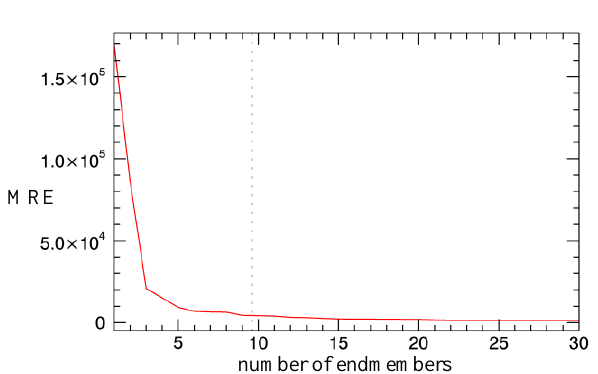
Figure 3 SMACC output: Behaviour of the maximum relative error (MRE) according to the number of endmembers.